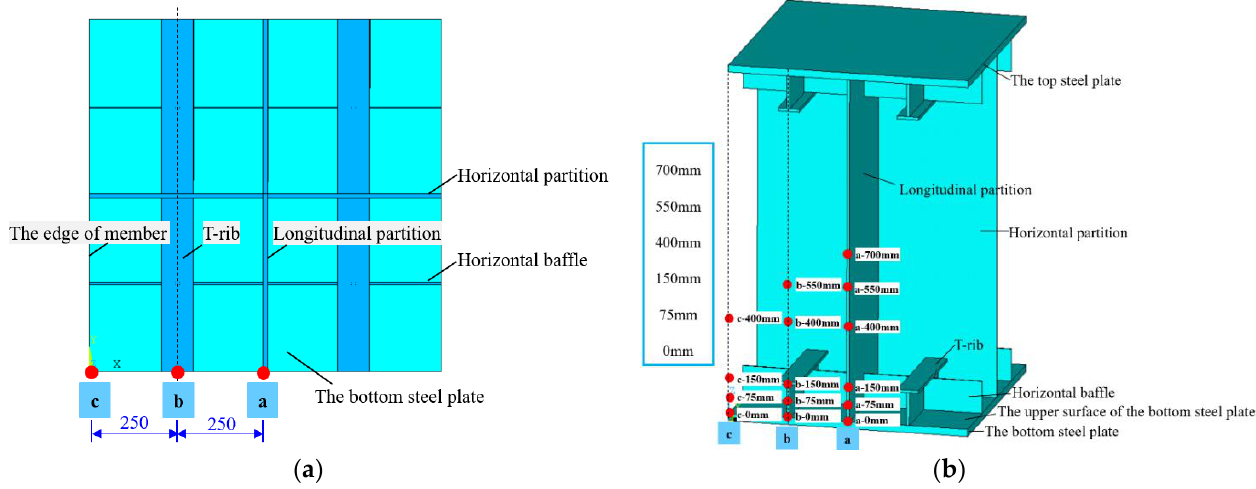
Figure 8. Distribution of thermocouples inside the member (unit: mm). ( a ) The horizontal position of the measuring points; ( b ) the longitudinal position of the measuring points. (2) Arrangement of temperature measuring points in the cavity (between the backfire side of the fireproof boards and the bottom steel plate) To study the protective effect of the fireproof layers on the tube structure and the influence of the fireproof board’s seam treatment on the steel shell structure, t wo meas- urement points, mid-1-bottom and mid-2-bottom, were placed in the middle of the lower surface of the bottom steel plate and were situated directly above the location of the fire- proof board’s seam. A measurement point was arranged at 25 cm left and r ight of the middle-1-bottom, named side-1-bottom and side-2-bottom, respectively. As the fireproof board was indirectly fixed on the surface of the steel shell through the angle steel, there was a certain height of the cavity air layer between the backfire surface of the fireproof board and the bottom steel plate (Figure 9). To study the direction and law of temperature transfer, the measurement points were arranged in the cavity, and the measurement points in the same vertical position were a group. The naming of the measurement points: the bottom position (mid, side) — number (1, 2) — vertical position (bottom, cavity, board). A set of measuring points in the middle, for instance, was given the names mid-1-bottom, mid-1-cavity, and mid-1-board (Figure 10). Different from the installation of fireproof boards, fireproof coatings were directly coated on the bottom surface of the member, so there was no cavity air layer and only the measurement points were arranged at the bot- tom of the steel shell. Figure 9. Position diagram of measuring points at the bottom of steel shell (unit: mm). ( a ) The lower surface of the bottom steel plate and measuring points position; ( b ) the specific location of the measuring